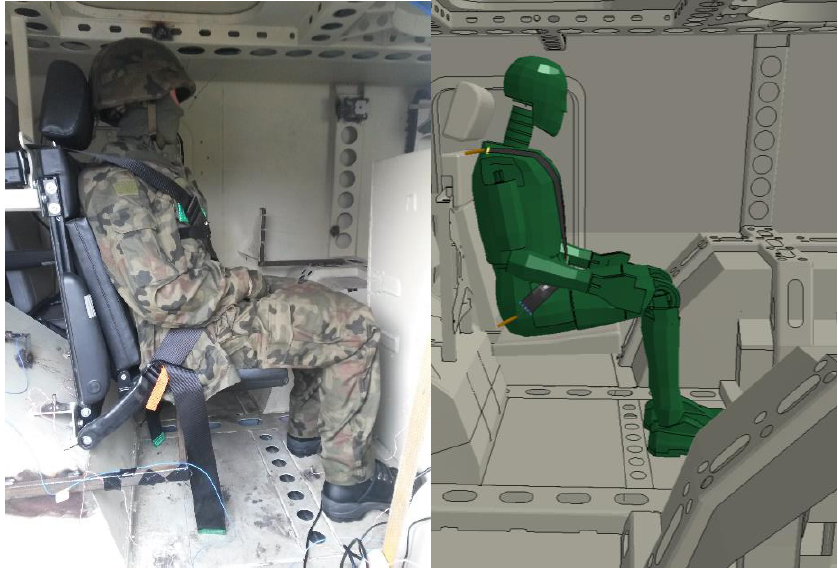
Figure 7. The view of the Hybrid III 50th Fast dummy during the experimental tests and in the numerical model